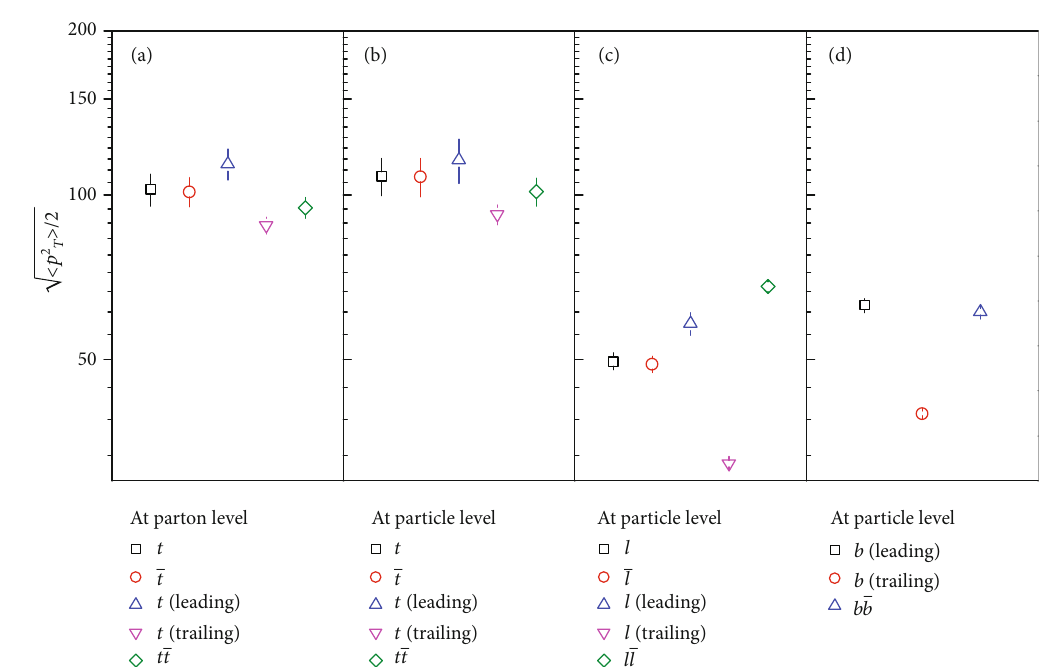
ffiffiffiffiffiffiffiffiffiffiffiffiffi p h p 2 i /2 T